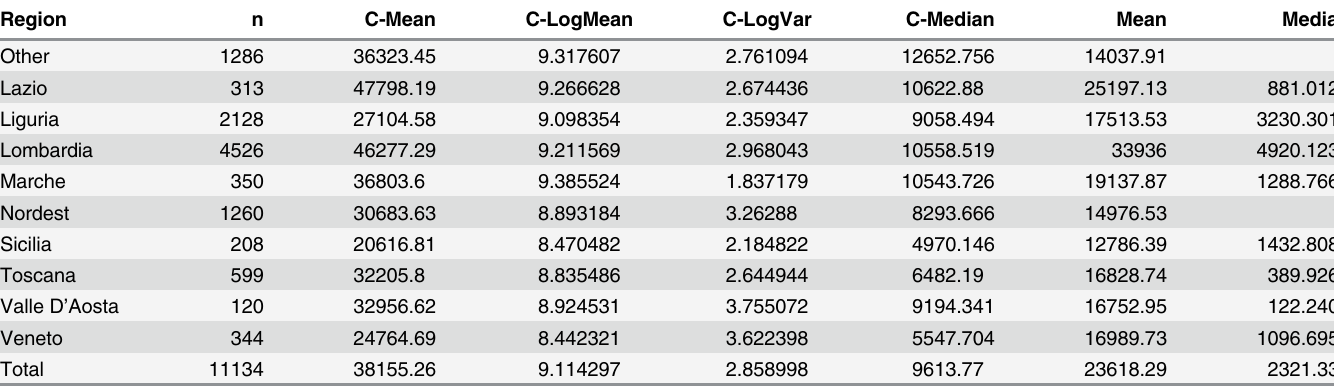
Table 13. Descriptive statistics of amounts by region identified as significant by the